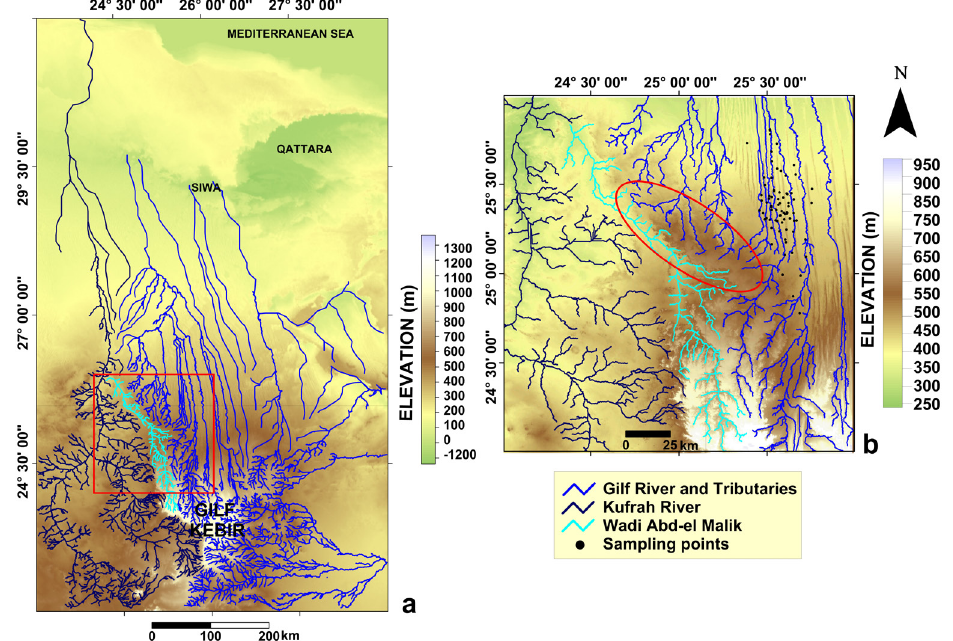
Figure 10. Paleodrainage maps: ( a ) Western Desert of Egypt; ( b ) inset of the red square in a, where the red ellipse indicates a probable connection zone between the Kufrah and Gilf River